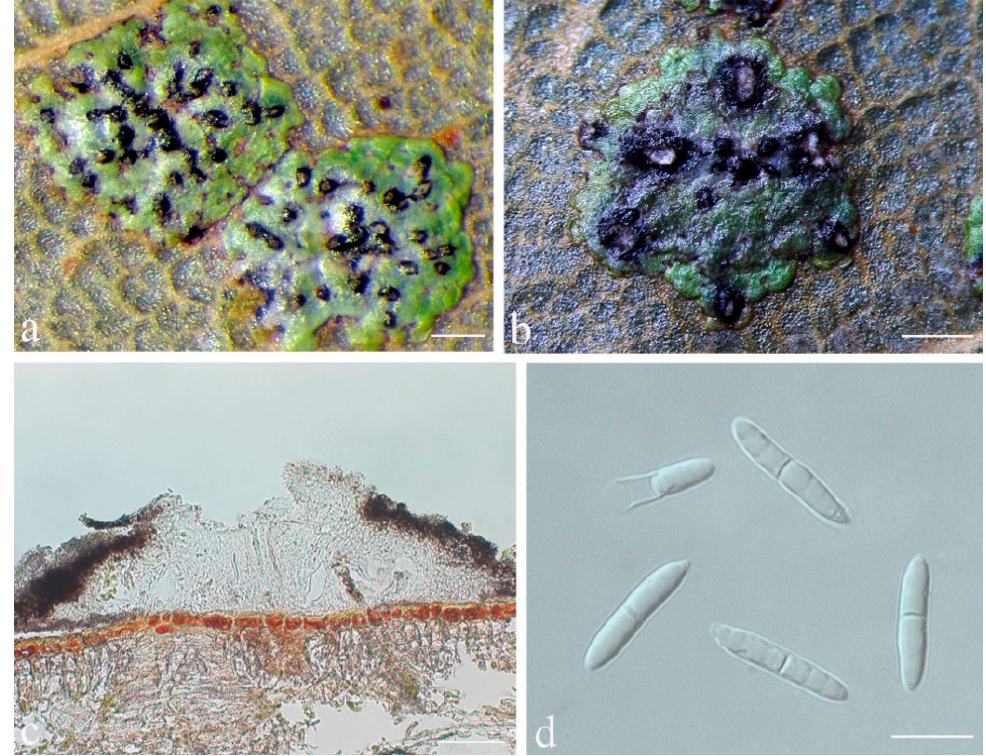
Figure 7. Strigula guangdongensis sp. nov. (holotype, HMAS–L0139169). ( a , b ) Thallus; ( c ) perithecia; ( d ) macroconidia. Scale bars: ( a , b ) = 200 μ m, ( c ) = 50 μ m, ( d ) = 10 μ m.